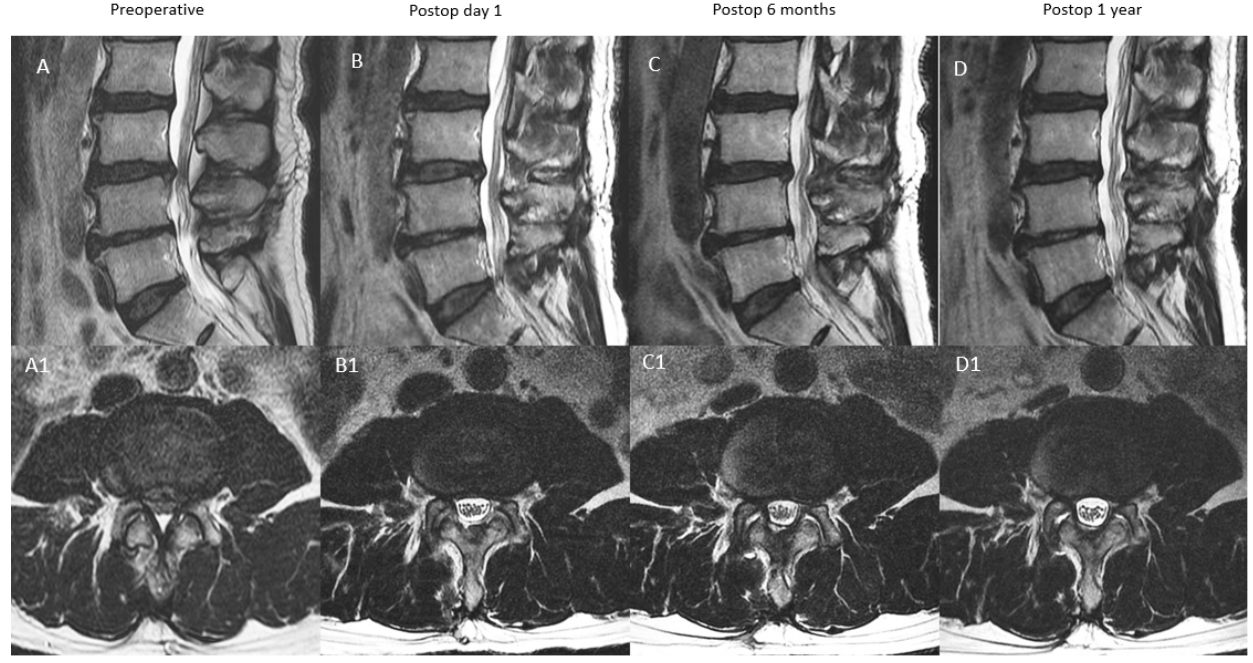
Figure 6. MRI appearance of remodeling patterns at preoperative, postoperative day 1, postoperative 6 months and postoperative 1 year with mid-sagittal cut in the top row and corresponding axial cut in the bottom row. Type C: expansion type, preoperative spinal stenosis ( A , A1 ) with increased spinal canal area on postoperative day one MRI ( B , B1 ). There was modest restenosis that occurred at postoperative 6 months ( C , C1 ), which improved modestly at postoperative one year with overall improved spinal canal area ( D , D1 ).